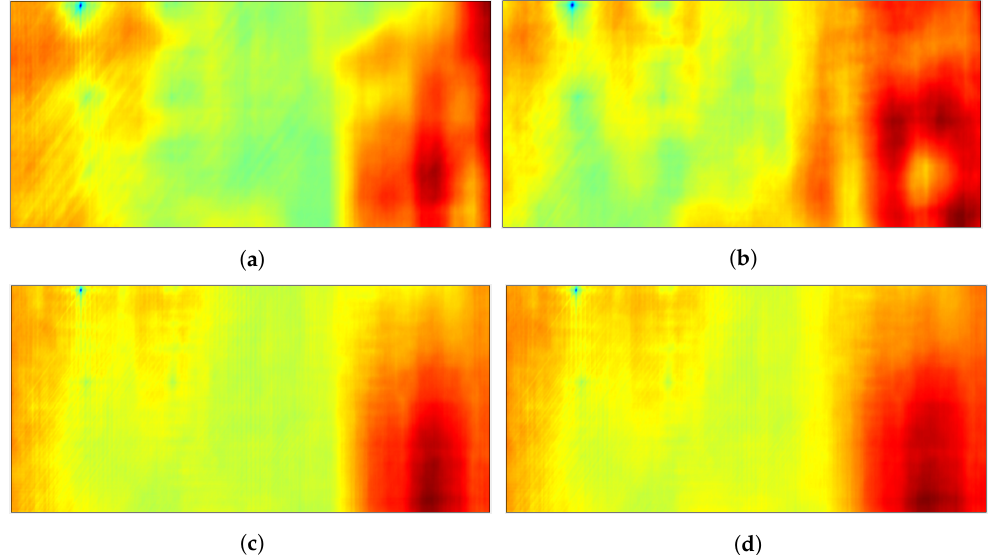
Figure 7. Loss in HSV over the image used for experiment 2. Blue indicates no loss and dark red the maximum loss: ( a ) hue; ( b ) saturation; ( c ) lightness; ( d )